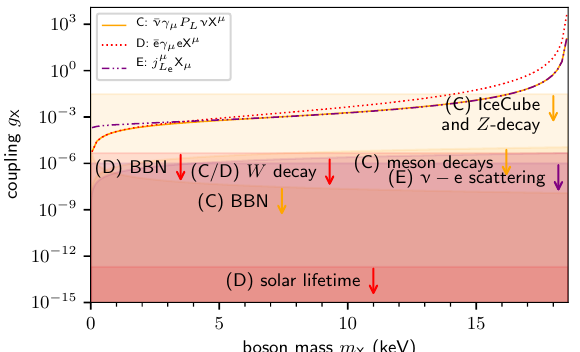
Figure 10 . Purely statistical sensitivity contours for keV-scale light vector bosons. Shown is the 90 % C.L. statistical sensitivity of a Katrin differential spectrum measurement with a new detec- tor system. Furthermore, the shaded areas mark the parameter regions allowed from constraints discussed in section